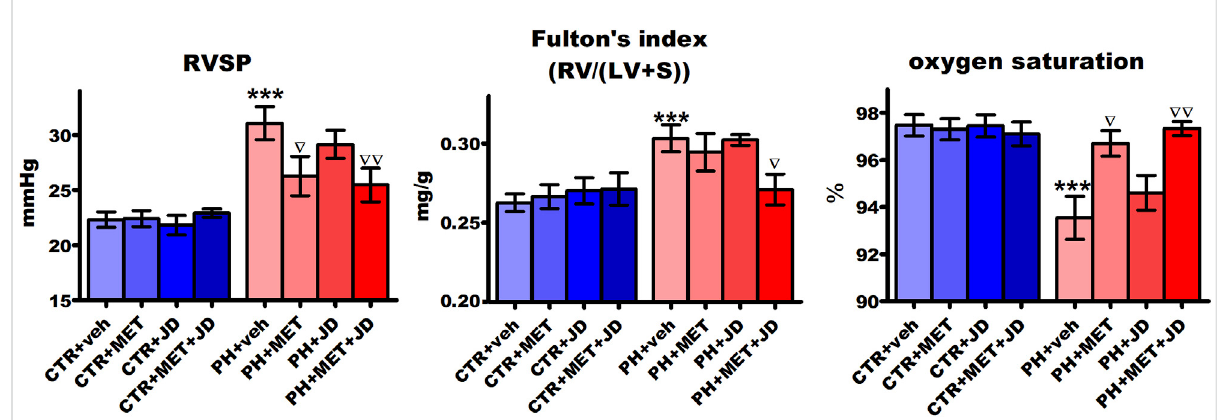
FIGURE 1 In fl uence of pulmonary hypertension, metformin (MET), JD5037 (JD) and/or their combination on right ventricular systolic pressure (RVSP), Fulton ’ s index (RV/(LV + S)) and oxygen saturation in monocrotaline-induced pulmonary hypertensive (PH) rats and their normotensive controls (CTR). MET(100 mg/kg), JD5037 (3 mg/kg)or their combinationwereadministered byoralgavage oncedaily for 21 days; controls received vehicles instead. Data are expressed as mean ± SEM; n = 9 – 20; *** p < 0.001 signi fi cantly different from CTR + veh; ∇ p < 0.05; ∇∇ p < 0.01 signi fi cantly different from PH + veh. RV – right ventricle; LV + S – left ventricle + interventricular septum.